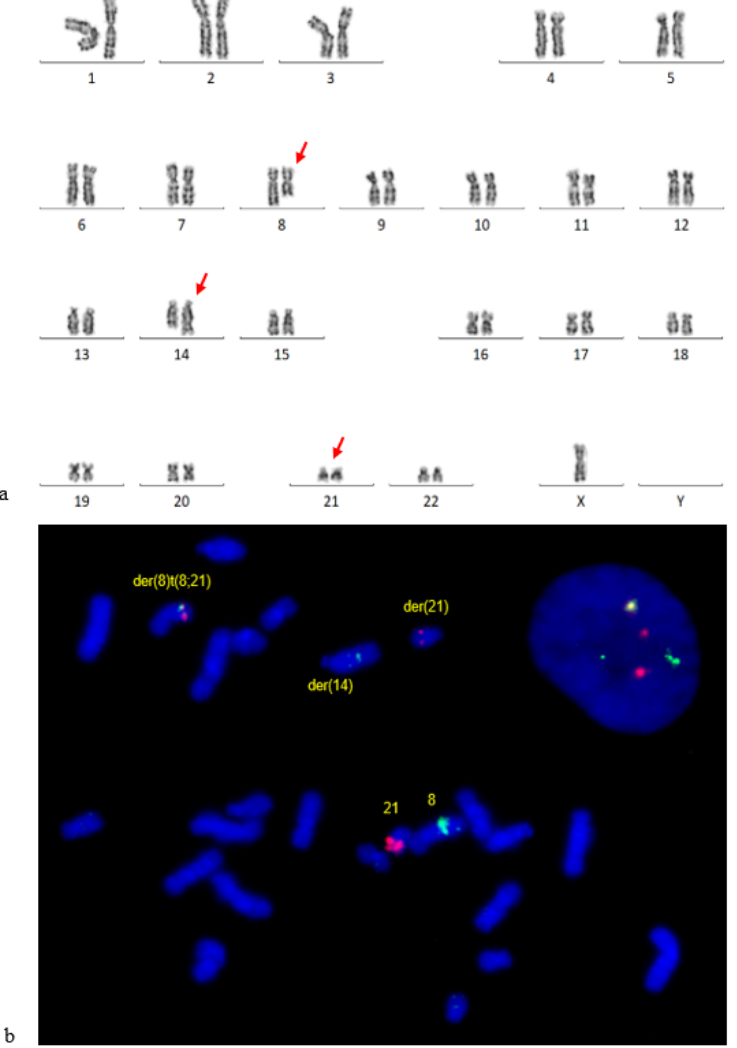
Figure 1. Cytogenetic findings of Patient 1. ( a ) A representative karyogram: 45,X,-Y,t(8;14;21)(q22;q32;q22). The derivative 21q was cryptic. ( b ) FISH using a dual-fusion probe RUNX1 (red)/ RUNX1T1 (green) revealed RUNX1::RUNX1T1 fusion on the derivative 8q.